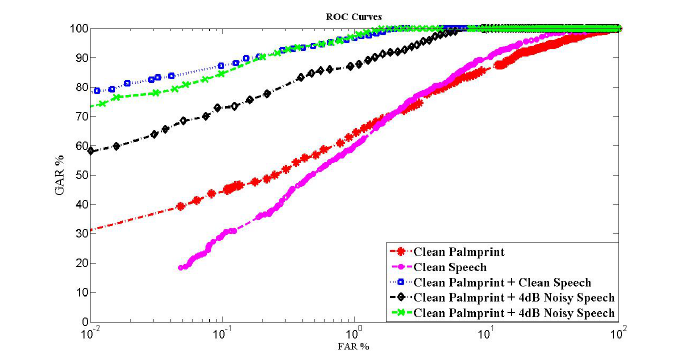
Figure 11. ROC curves for match score level fusion of clean palmprint using ICA II MM with speech (both clean and